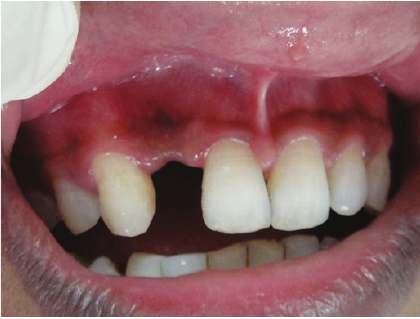
Figure 1: Preoperative view of the edentulous area showing concav- ity on the labial surface.